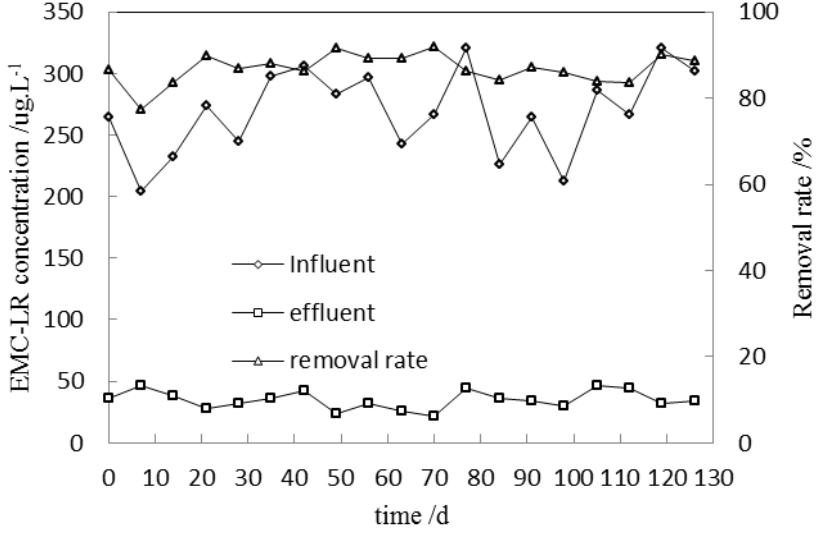
Figure 5. Extracellular microcystin-loading rate (EMC-LR) removal by the anaerobic baffled filter